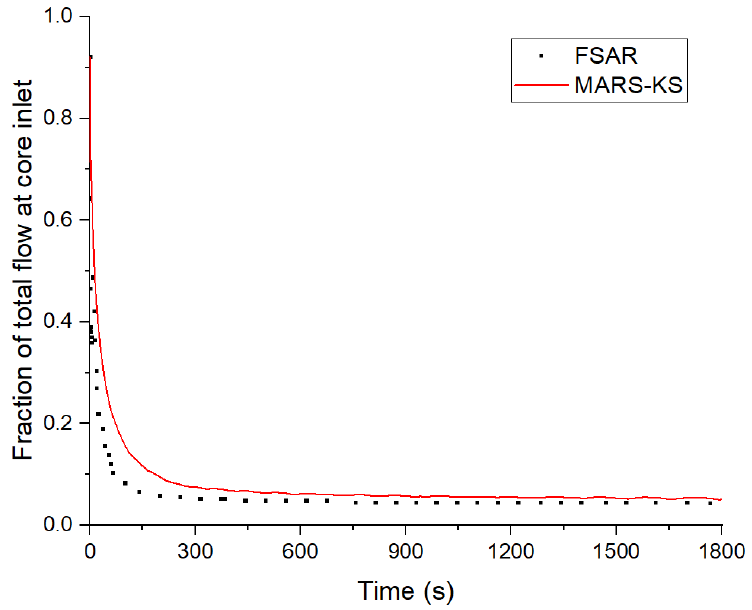
Figure 4. Comparison of total mass flow rate.